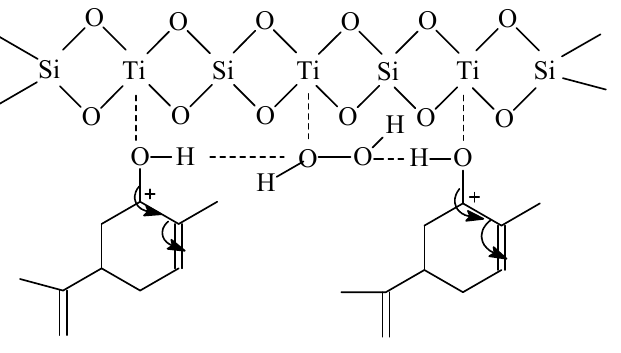
Figure 3. The mechanism of carvone formation over the titanium silicalite